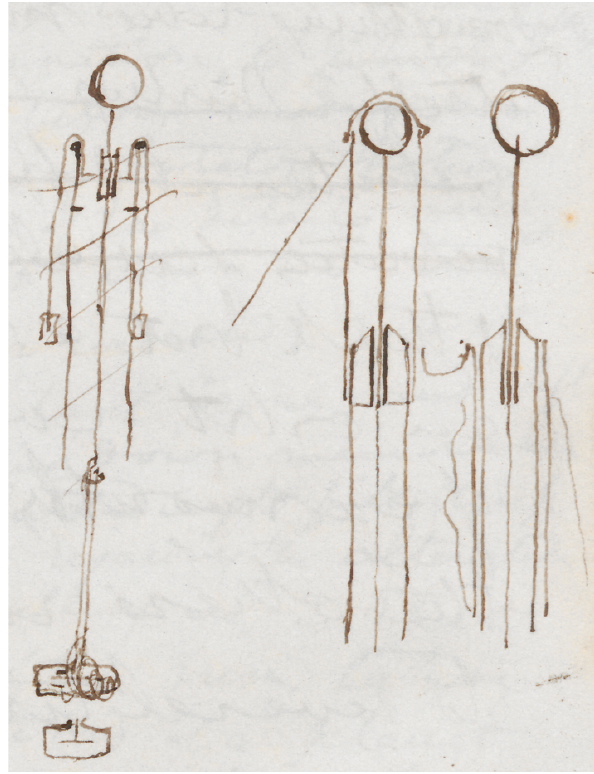
Figure 1. First sketches of an instrument for measuring potential gradient, from Thomson (1856). The sketch is marked “Observa- tions of atmospheric electricity” and on the same page is a sketch for an electroscope to be used with the instrument. The sketches that are not crossed out may indicate a method for exposing and enclosing the ball, and looking for the induced change, similar to the principle of operation of the winched can sensor and its 20th century version, the field